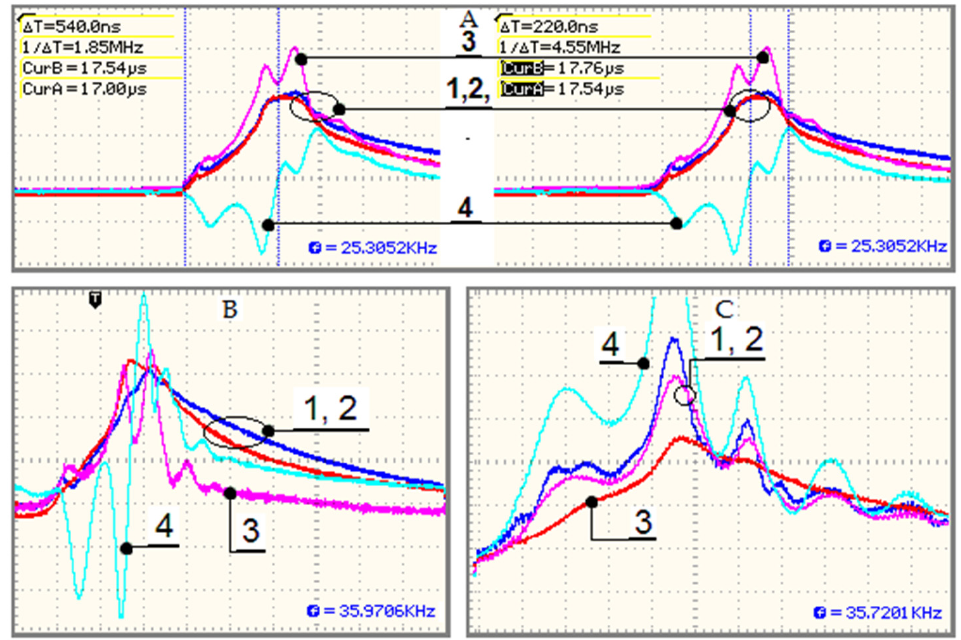
Figure 7. Current mismatch amongst four paralleled IGBT transistors. ( A , B ) switched-on with a delay of transistor 4; ( C ) switched-on prematurely of transistor 4; 1, 2—transistors with the same production lot; 3, 4—two different production lots. Electricity 2021 , 2 , FOR PEER REVIEW